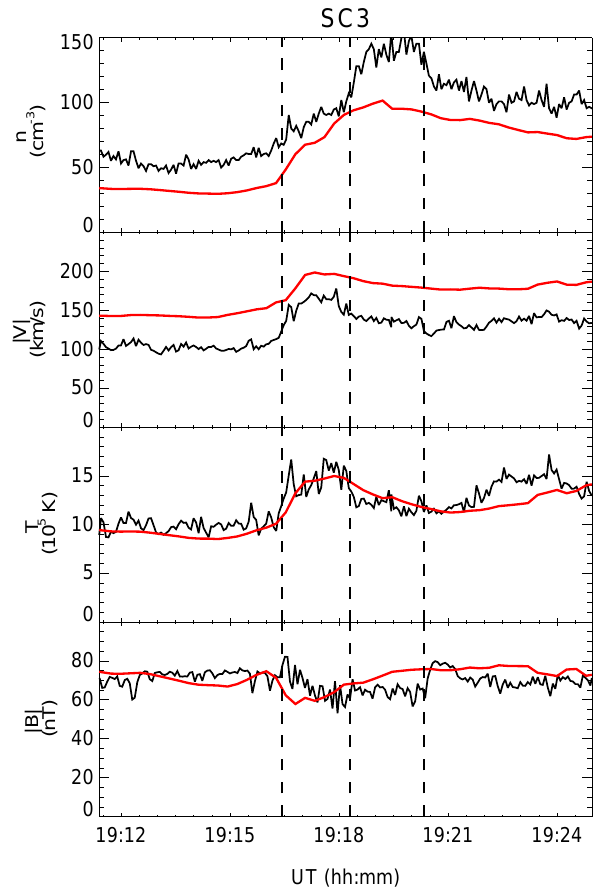
Fig. 6. Ions density, total speed, temperature and magnetic field magnitude observed by CIS/HIA and FGM instruments onboard SC3 (black lines) and predicted by the MHD code (red lines). Verti- cal dashed lines mark the three observed discontinuities (see details in